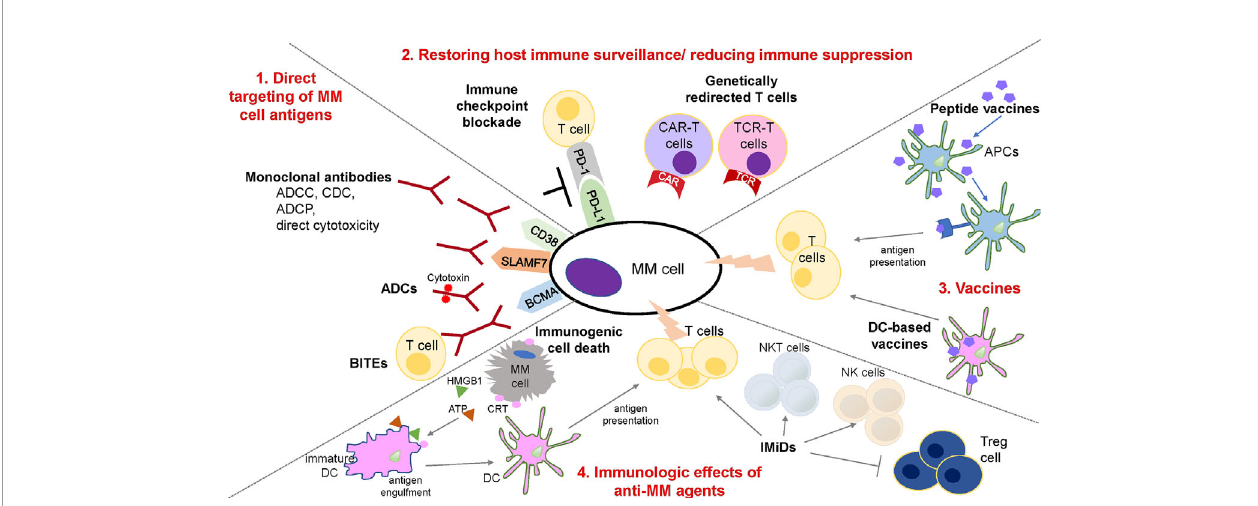
FIGURE 1 | Schematic overview of immune therapies in MM. 1. Strategies for the direct targeting of MM cell antigens includes: (a) moAbs: anti-CD38 and -SLAMF7 antibodies induce ADCC, CDC, ADCP, and direct cytotoxic effect on MM cells; (b) ADCs: conjugation of moAbs and cytotoxic compounds provides direct and selective tumor killing; (c) BiTEs: dual interaction with surface antigen of tumor cells and the TCR complex enables T cell activation and tumor lysis of MM cells. 2. Restoration of host immune surveillance and decrease of immune suppression can be achieved by the blockade of immune-checkpoint, such as PD-1/PD-L1 axis, that are responsible for inactivation and loss of proliferative capacity of T cells; or by the use of genetically redirected T cells including CAR-T and TCR-T cells. CAR-T cells mediate MHC-unrestricted tumor cell killing via recognition of tumor antigen. TCR-T cells mediate MHC-restricted tumor cell killing by recognizing the intracellular antigen fragment presented by MHC molecules. 3. Peptide- or DC-based vaccination represents an additional strategy to increase a MM speci fi c anti- tumor immunity. Peptide vaccines binds to restricted MHC molecule in APCs and after intracellular processing, peptide/MHC complex is transported to the cell surface for antigen presentation and activation of T cells. In DC-based vaccines, DCs are generated to present tumor associated antigens to T cells. 4. Anti-MM agents such as IMiDs and PIs may affect the immune compartment composition and increase anti-MM immune response. IMiDs increase and stimulate T, NK, and NKT cells, along with a decrease of immunosuppressive Treg cells. Novel reports also show the ability of anti-MM agents, such as bortezomib to induce immunogenic cell death (ICD) and stimulate an immune response against MM cells. Speci fi cally, dying tumor cells expose speci fi c damage associated molecular patterns (DAMPs) that induce the functional maturation of DCs, and the ef fi cient presentation of tumor antigens to the T cells. ADCC , Antibody-dependent cellular cytotoxicity; ADCP , Antibody-dependent cellular phagocytosis; CDC , Complement-dependent cytotoxicity; ADC , Antibody drug conjugate; BiTE , Bi-speci fi c T cell engager; CAR , Chimeric antigen receptor; TCR , T cell receptor; APC , Antigen presenting cell; NK , Natural Killer; Treg , regulatory T cells; DC , dendritic cell; CRT ,